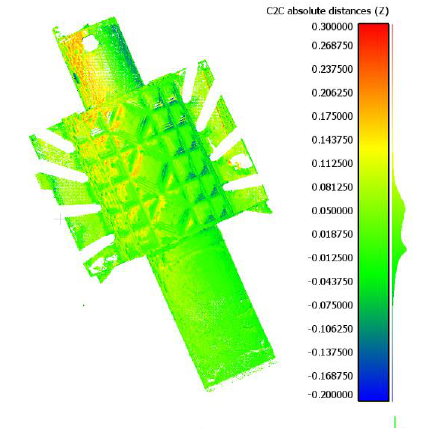
Figure 9 . Distances along the z-axis resulting from the Cloud- to-Cloud application, the registration of the two point clouds was not applied.